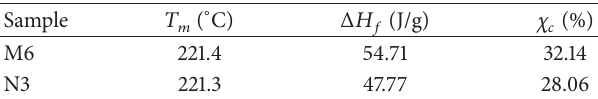
Figure 3: DSC melting curves of the M6% and N3% samples. Table 5: Results of M6% and N3% sample heat